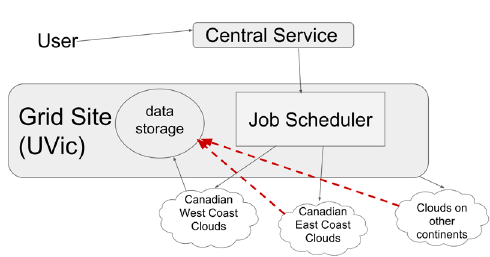
Figure 1: Grid site with distributed compute and traditional local storage, examples for ine ffi cient data access are shown in red